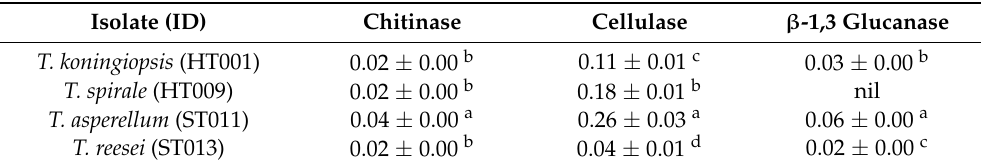
Table 8. Enzyme activities ( µ mol/min) of four Trichoderma isolates in liquid cultures (see Section 2.4.2 for media composition and growth